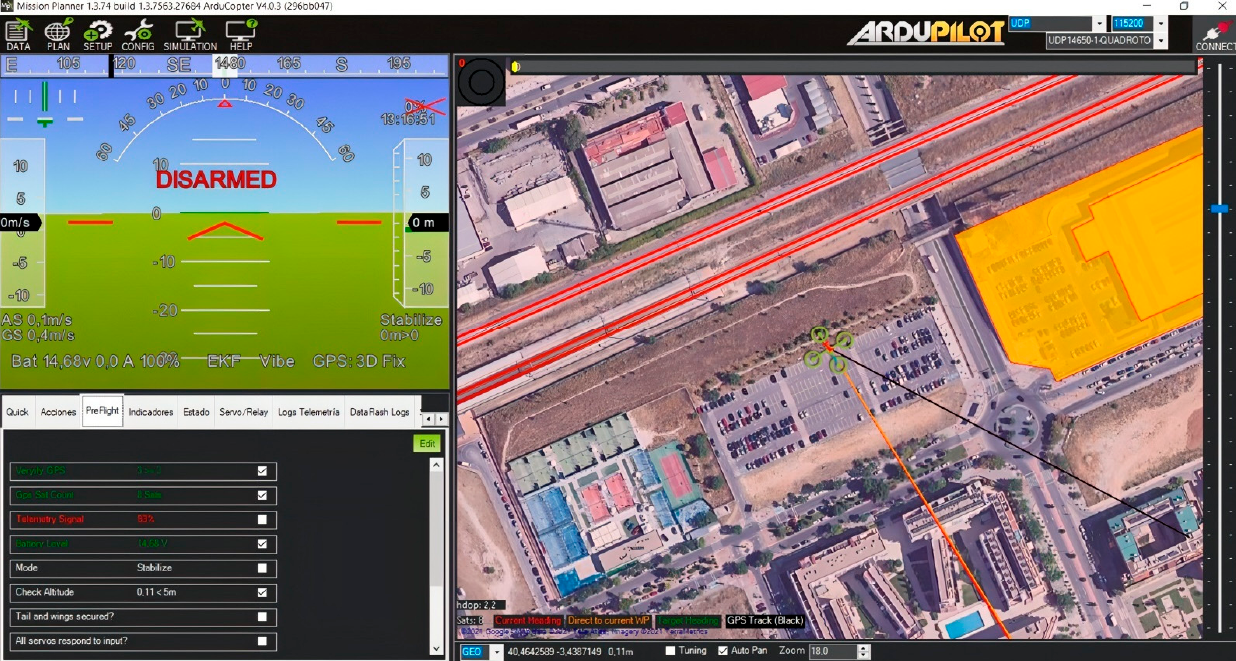
Figure 9. ArduPilot Mission Planner tool during one of the experiments.